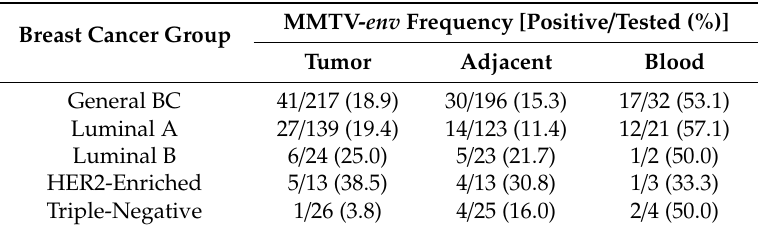
Table 2. Prevalence of Mouse Mammary Tumour Virus (MMTV)-like env among BC subgroups. Breast Cancer